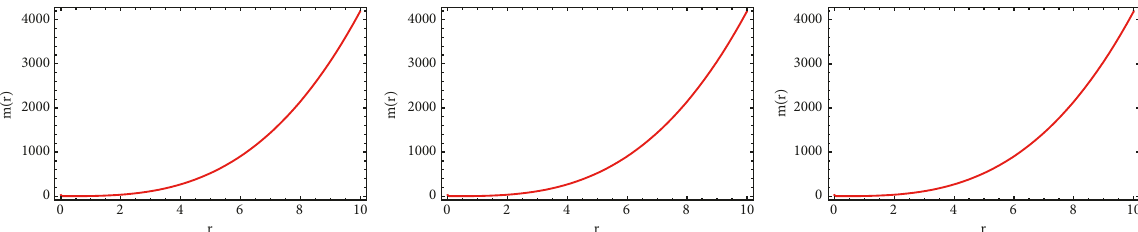
Figure 19: This figure represents the variation of 𝑚(𝑟) versus 𝑟 (km) for the strange star taking 𝛽 = 1 , 𝛽 = 2 , and 𝛽 = 3 .